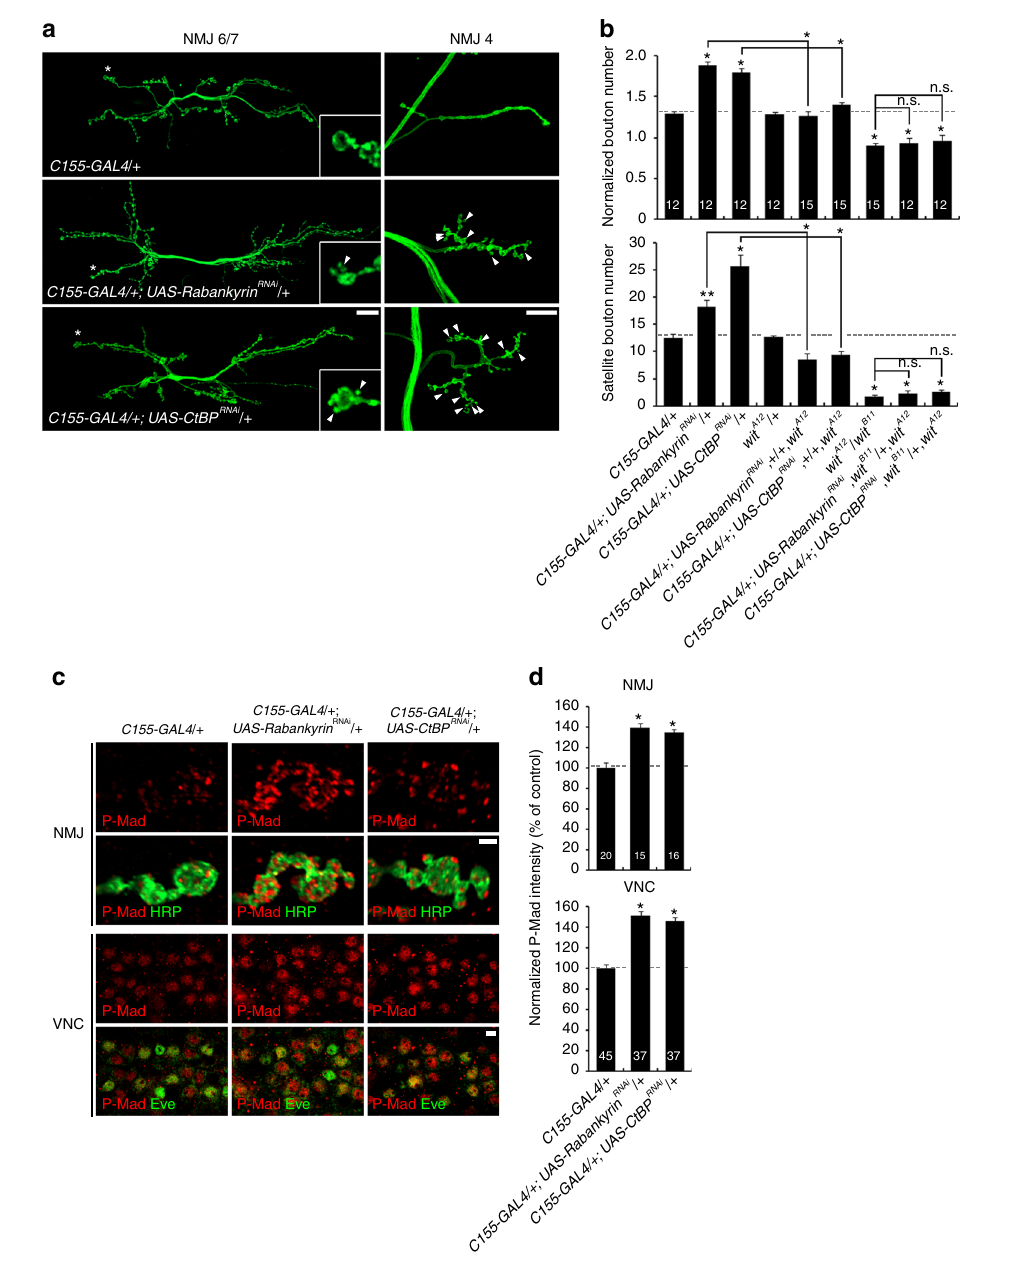
Fig. 8 Rabankyrin and C-terminal-binding protein (CtBP) inhibit bone morphogenetic protein (BMP)-dependent synaptic development. a Presynaptic Rabankyrin or CtBP RNA interference (RNAi) induces BMP-dependent synaptic overgrowth. Sample images of anti-HRP-labeled neuromuscular junctions (NMJs) 6/7 and 4 in the indicated genotypes. Insets show high-magni fi cation boutons marked by asterisks. Satellite boutons are indicated by arrowheads. b Quanti fi cation of total (top) and satellite (bottom) bouton number at NMJ 6/7. Note that synaptic overgrowth with Rabankyrin or CtBP knockdown is sensitive to wit level. c Presynaptic Rabankyrin or CtBP RNAi increases P-Mad in motor neurons. Single confocal sections of NMJ 6/7 (top) and ventral nerve cord (VNC; bottom) co-labeled for anti-P-Mad and anti-HRP (NMJ) or anti-Eve (VNC). d Quanti fi cation of P-Mad intensity normalized to HRP or Eve. Bar graphs indicate mean ± s.e.m. The number of NMJs ( b ), NMJ branches ( d , upper panel), or Eve-positive motor neurons ( d , lower panel) analyzed for each genotype is indicated inside bars. All comparisons against C155 - GAL4 / + unless indicated (one-way analysis of variance with Tukey – Kramer post hoc test; * P < 0.001; ** P < 0.01; n.s. not signi fi cant). Scale bars: a , 20 μ m; c , 2 μ m (NMJ); c , 5 μ m